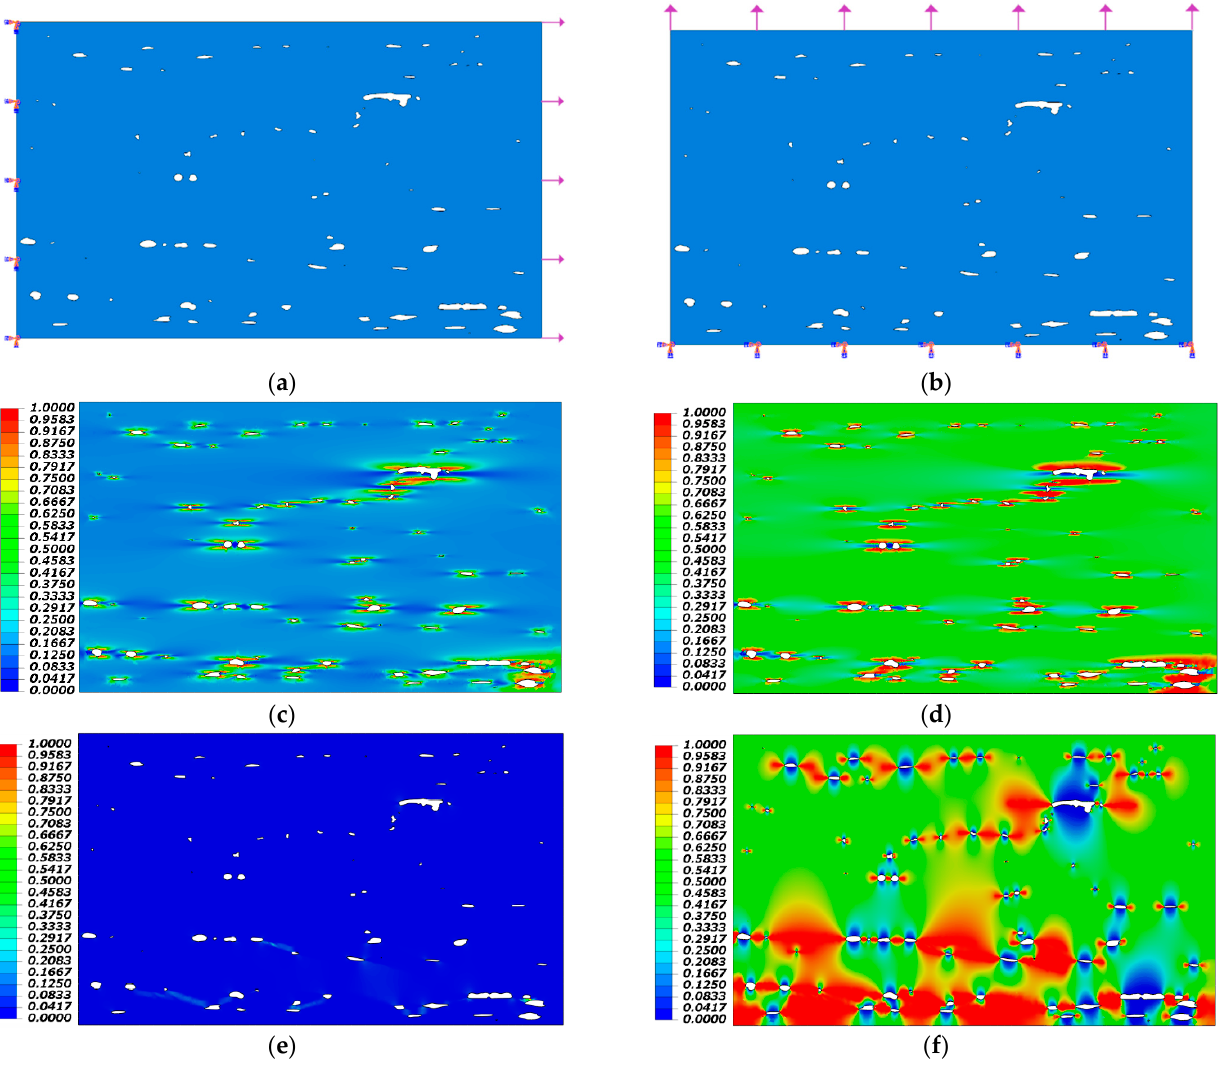
Figure 11. Results of numerical simulation showing: ( a ) load direction in longitudinal direction; ( b ) load direction in the transverse direction; ( c ) fiber failure under longitudinal loading; ( d ) matrix failure under longitudinal loading; ( e ) fiber failure under transverse loading; ( f ) matrix failure under transverse loading.